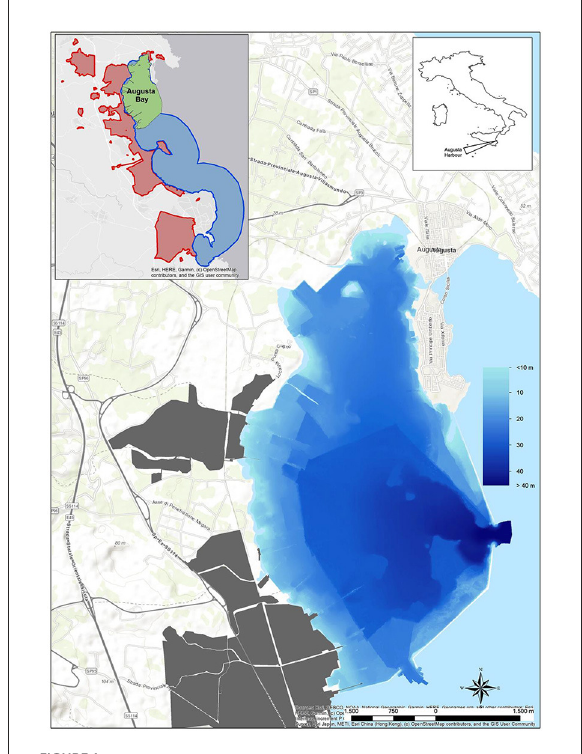
FIGURE1 Augusta Bay with the sea bottom depth. In gray color, the industrial area. In the small box is reported, in addition to Augusta Bay (green area), the whole extension of the Site of National Interest named “Priolo-Gargallo” on land (red area) and sea (blue